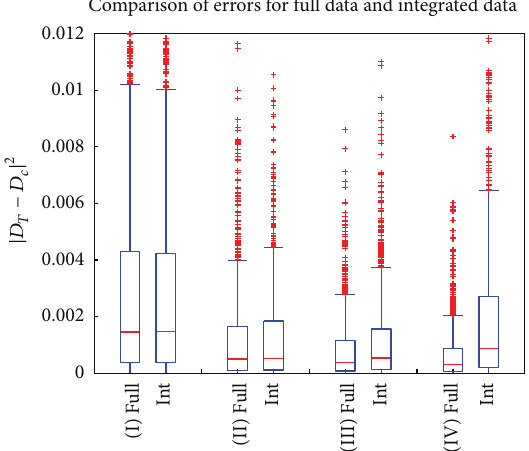
Figure 5: Comparison of the squared errors |𝐷 𝑐 − 𝐷 𝑇 | 2 for the full data approach and the integrated data approach for four data regions with different length of the spatial interval (the factor 𝐿/ 2 𝑟 is equal to 1 , 5 , 10 , 20, resp.) labeled as (I)–(IV); time interval was the same for all cases [ 0 , 6 ] . In the pairs, the left and right boxplot correspond to using full data (Full) and spatially integrated data (Int),